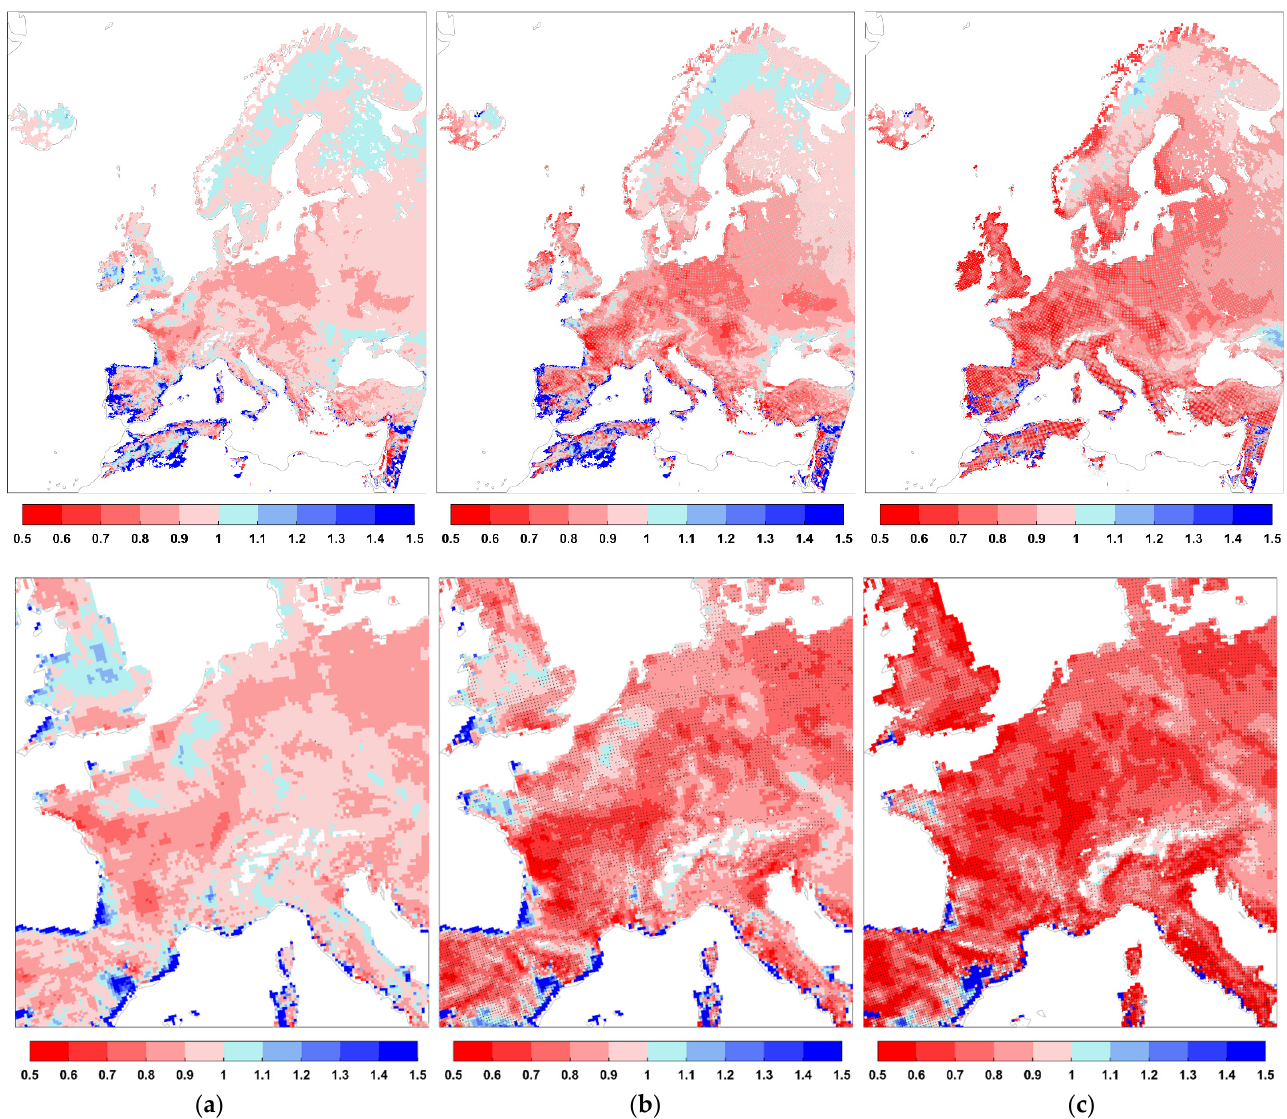
Figure 5. FC maps (ensemble mean) for characteristic ground snow loads, associated to 0.02 probability of exceedance in one year, in the Euro-Cordex domain (first row) and a focus on central Europe (second row). Three moving time windows are considered (1971–2010 ( a ), 1991–2030 ( b ), and 2011–2050 ( c )) in the elaboration with respect to 1951–1990, based on RCP8.5 scenario. The dots indicate statistically significant changes in the distribution of annual maxima at the 5% level.